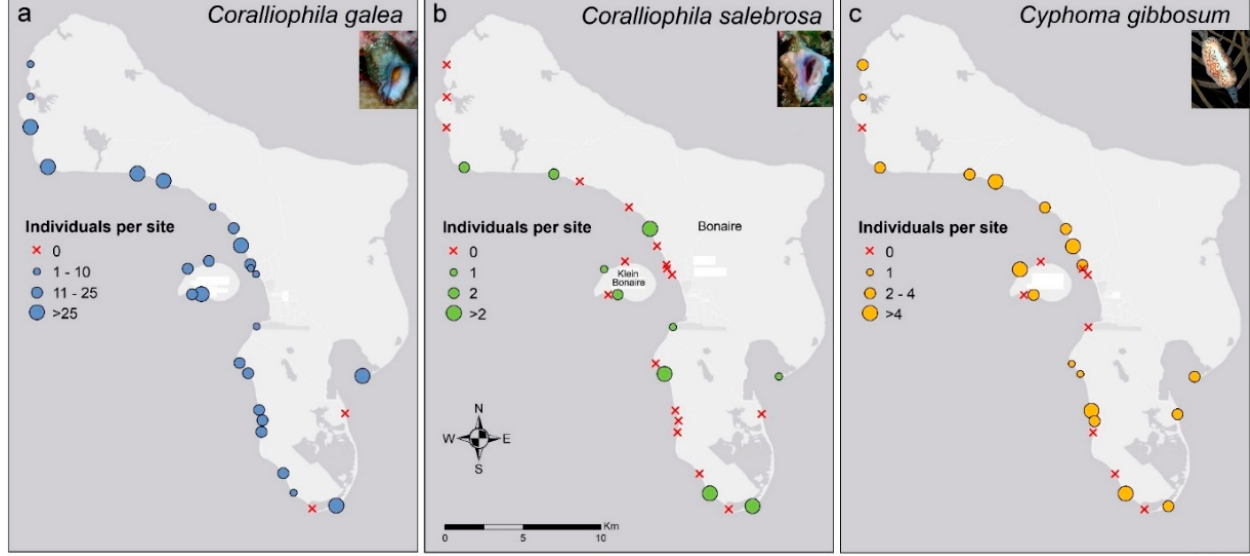
Figure 2. Distribution of three corallivorous snail species at 28 localities around Bonaire. Coralliophila galea was the most commonly observed species, represented by 575 individuals on 101 scleractinian host corals at 26 out of 28 localities. Up to 36